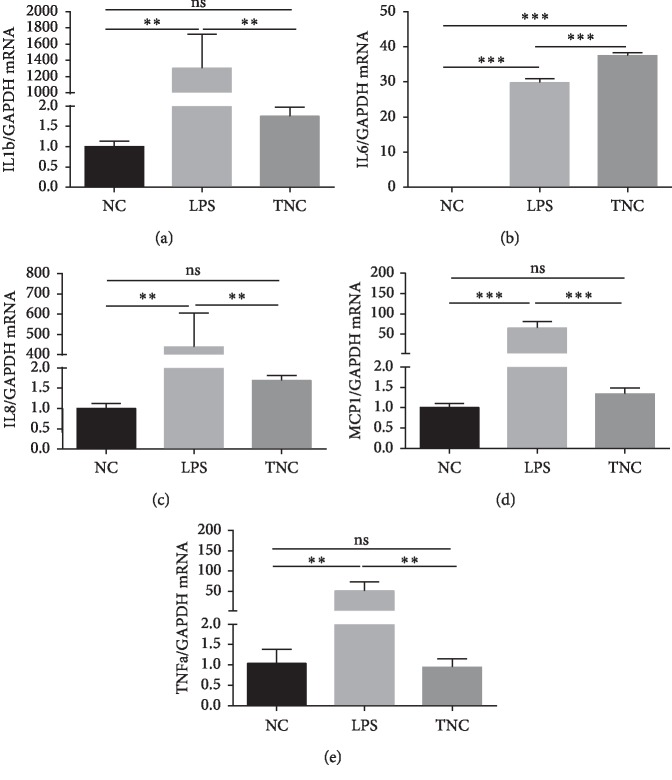
TNC promotes IL-6 expression in THP-1 cells. THP-1 cells were stimulated with LPS or TNC for 6 hours. mRNA expression of IL-1β (a), IL-6 (b), IL-8 (c), MCP-1 (d), and TNF-α (e) was assessed in the three groups (n = 3/group). ∗∗P < 0.01 and ∗∗∗P < 0.001.